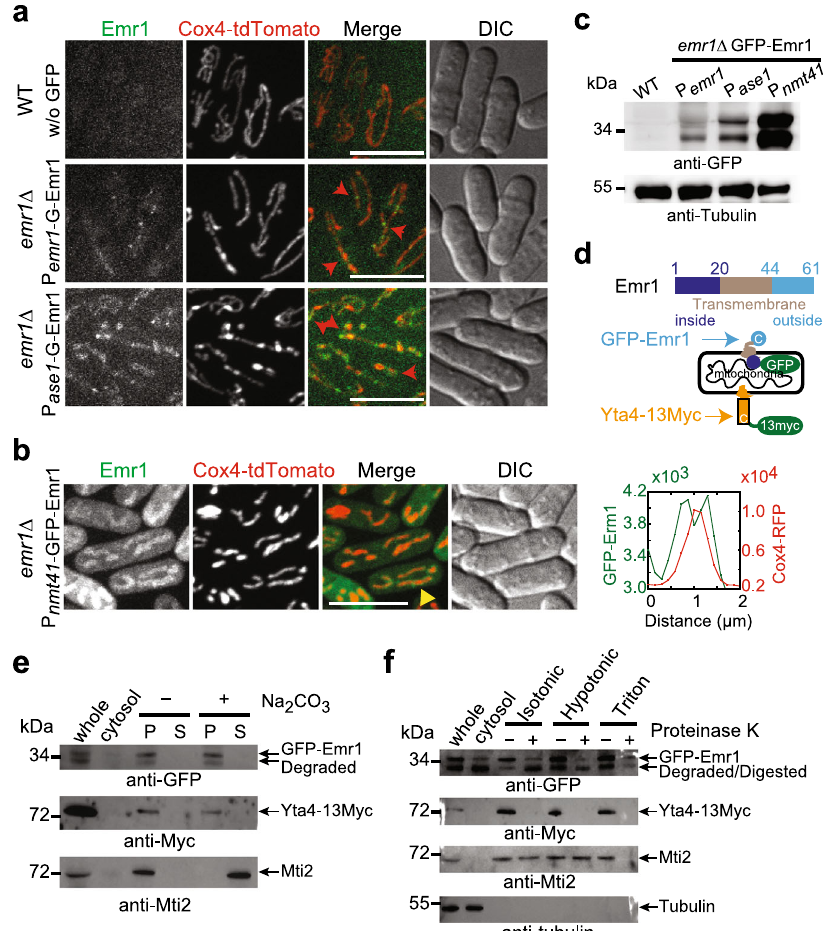
Fig. 2 Emr1 is a mitochondrial outer membrane protein. a Maximum projection images of WT cells expressing only Cox4-tdTomato or emr1 Δ cells expressing Cox4-tdTomato and GFP-Emr1 either from emr1 ’ s own promoter (P emr1 ) or an ase1 promoter (P ase1 ). Emr1 localized along mitochondria and enriched at some places as foci (red arrows) (See supplementary Fig. 2 for all Z-stack images). Scale bar, 10 μ m. b Maximum projection images of emr1 Δ cells expressing Cox4-tdTomato and GFP-Emr1 from the nmt41 promoter (P nmt41 ) in EMM5S medium without thiamine. Line-scan intensity measurement was performed perpendicularly along the mitochondria marked by the yellow arrowhead and the measurement data is shown as a plot graph on the right of the image. Scale bar, 10 μ m. c Western blotting assays. The expression levels of GFP-Emr1 as shown in a and b were analyzed by western blotting with antibodies against GFP and tubulin, respectively. d Domain structure of Emr1. A diagram illustrates the localization of GFP-Emr1 and Yta4-13Myc (Msp1 in budding yeast, containing a transmembrane domain at the N-terminus) on the mitochondrial outer membrane. C indicates the C-termini of proteins. e Carbonate extraction of isolated mitochondria from cells expressing GFP-Emr1 and Yta4-13Myc. whole and cytosol indicates whole-cell lysate and the cytosol fraction from mitochondria isolation, respectively; P and S indicate insoluble membrane and soluble fractions, respectively; − and + indicate the absence and presence of sodium carbonate, respectively. Similar to Yta4-13Myc, GFP-Emr1 is present in the insoluble membrane fractions. Mti2 is a mitochondrial matrix protein. Western blotting assays were performed with antibodies against GFP, Myc, and Mti2, respectively. f Proteinase K digestion assays. whole and cytosol indicate whole-cell lysate and the cytosol fraction from mitochondria isolation, respectively. Isolated mitochondria from cells expressing GFP-Emr1 and Yta4-13Myc were incubated in the isotonic buffer (indicated as Isotonic ), hypotonic buffer (indicated as Hypotonic ), or hypotonic buffer containing 1% Triton X-100 (indicated as Triton ), followed by digestion with proteinase K. The absence and presence of proteinase K are indicated by − and + , respectively. Western blotting assays were performed with antibodies against GFP, Myc, Mti2, and tubulin,